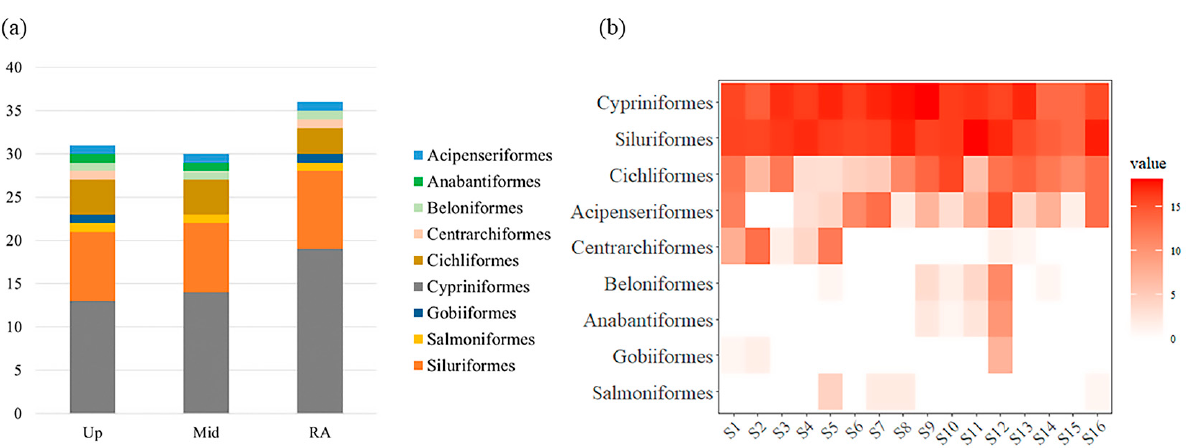
Figure 2. Comparison of α diversity in different sections: ( a ) Shannon Index; ( b ) Simpson Index.